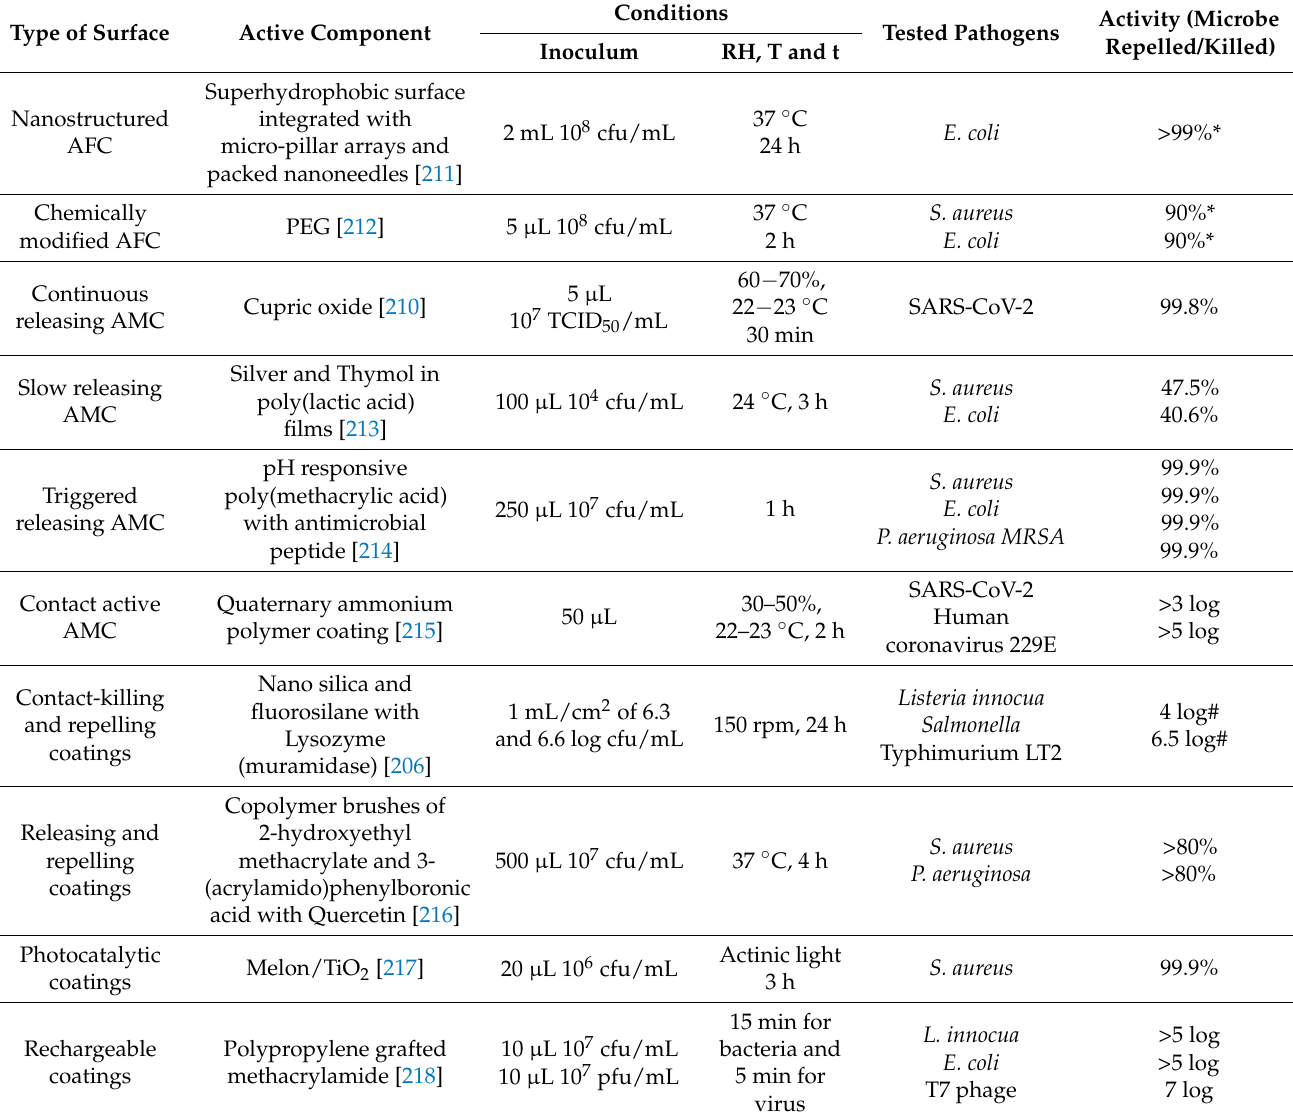
Table 3. Efficacy of self-disinfecting coatings toward critical antimicrobial